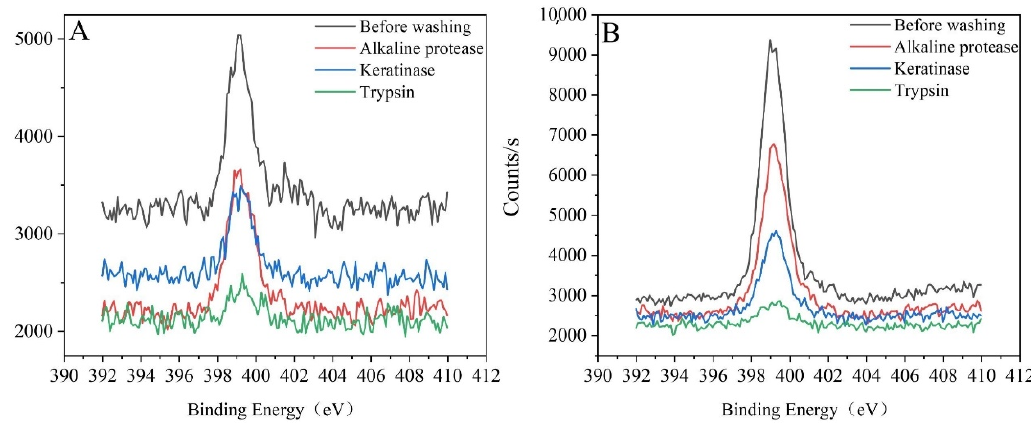
Figure 2. Infrared spectra of dirty cloth before and after washing with different proteases. ( A ) Protein-fouling cloth. ( B ) Blooddirty cloth.